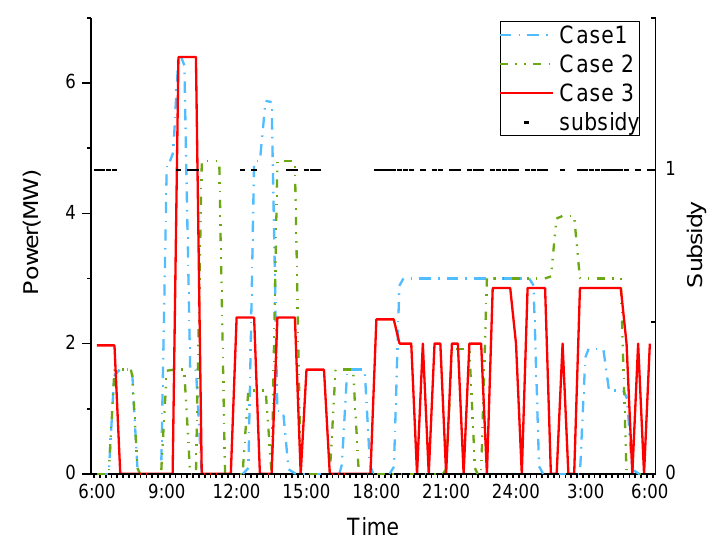
Figure 9. The effect of subsidies on flexible load.